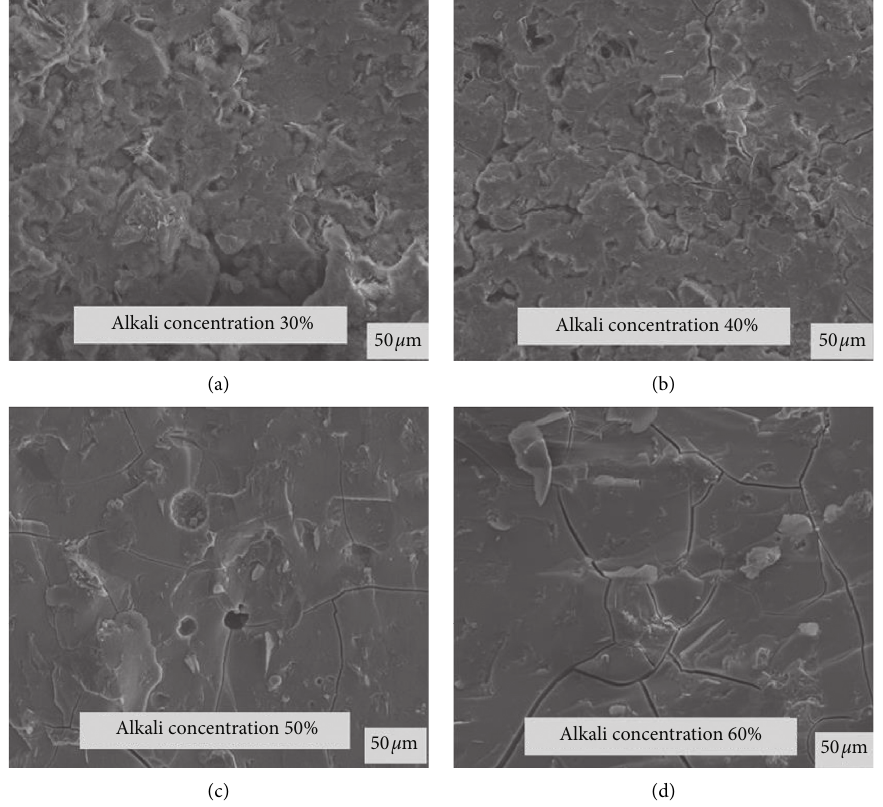
Figure 10: SEM images of sections of geopolymer blocks.